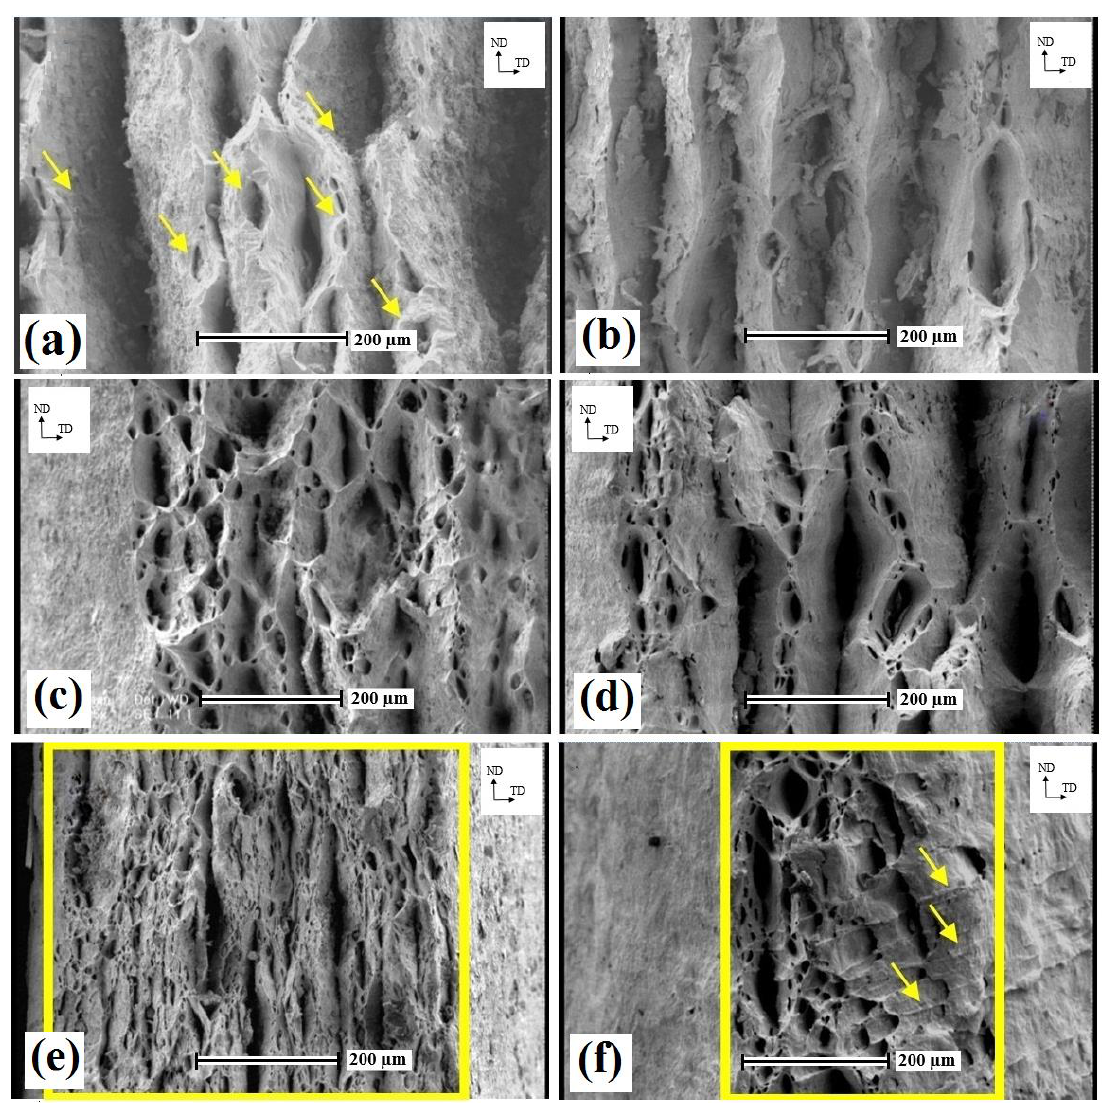
Figure 7. SEM micrographs of the fractured surface of ( a ) Pb – 0.5%Co – 5pass, ( b ) Pb – 0.5%Ag – 5pass, ( c ) Pb – 0.5%Co – 7pass, ( d ) Pb – 0.5%Ag – 7pass, ( e ) Pb – 0.5%Co – 10pass, and ( f ) Pb – 0.5%Ag – 10pass.